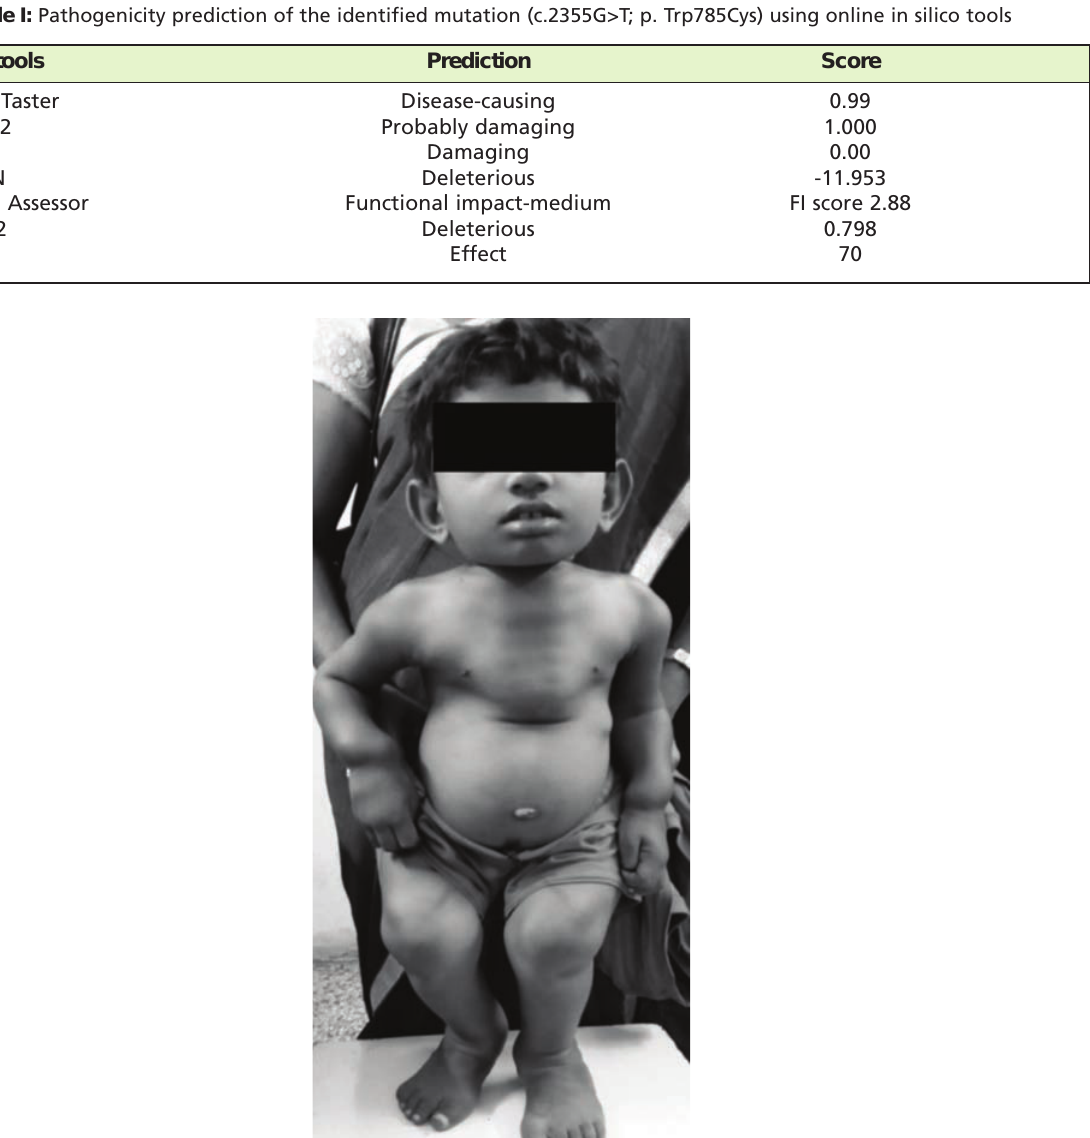
Malaysian Orthopaedic Journal 2022 Vol 16 No 2